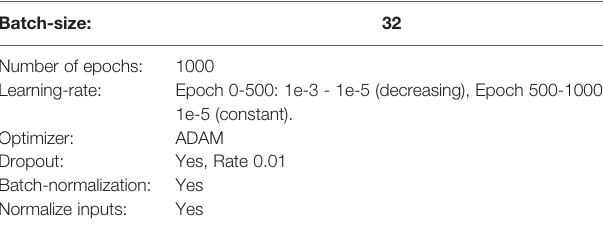
TABLE 2 | Con fi guration of the SphCNN prediction